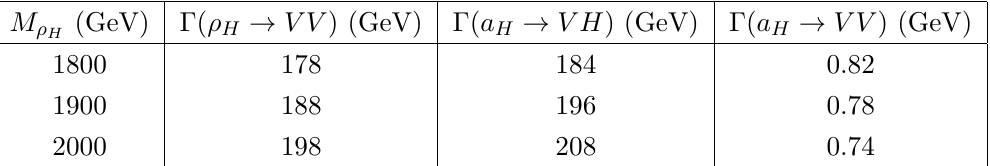
= 3 : 862 and M a = H H